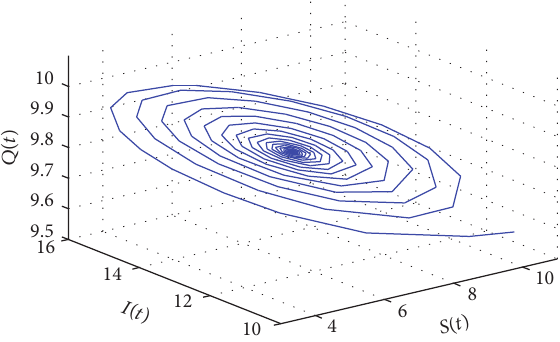
Figure 2: The phase plot of 𝑆 , 𝐼 , and 𝑄 when 𝜏 1 = 1.3025 < 1.3265 = 𝜏 10 .